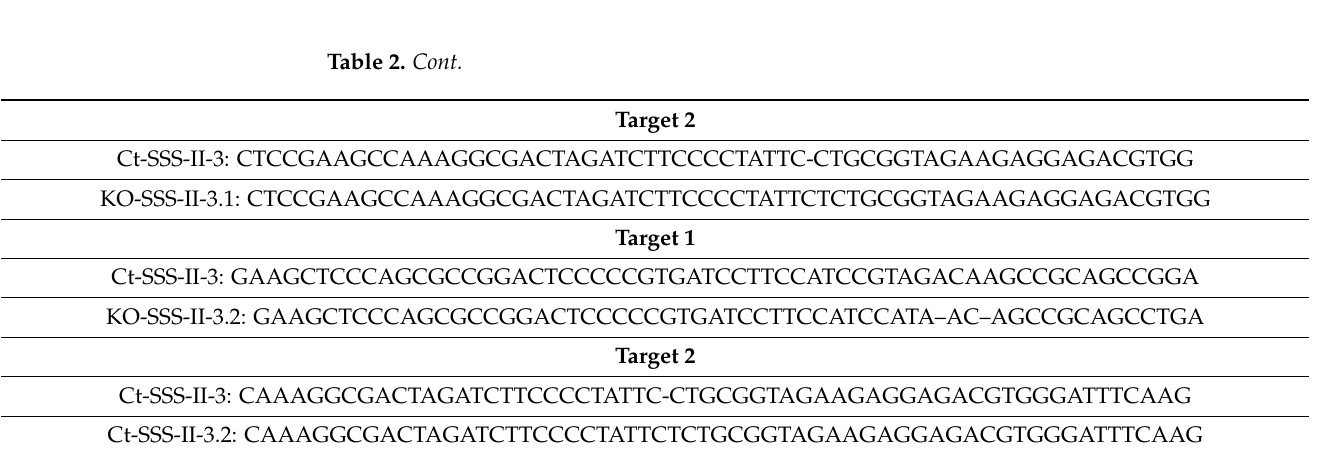
Figure 11. Structural differences in molecular starch of rice at SEM magnification of 2.5 KX for trans- verse section of grains of wild types of MTU-1010, PB 1509, and Cas9-free knockouts of SSSII-1, 2, and 3 .